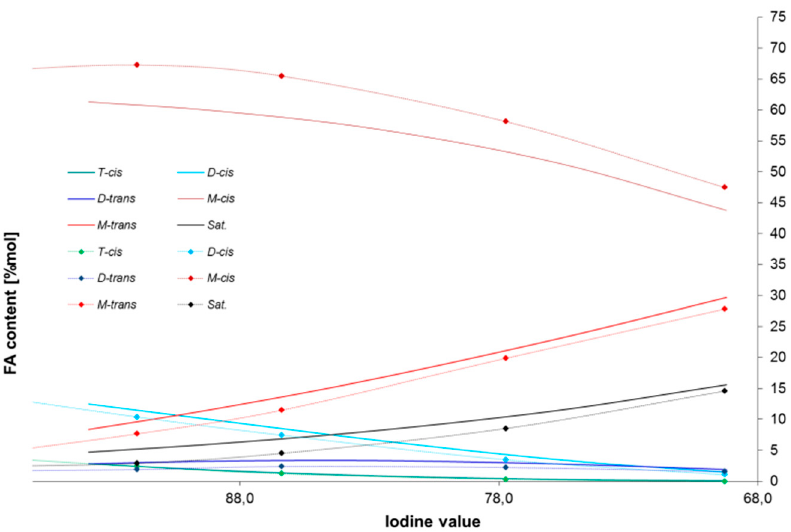
Figure 5. Predicted (solid line) and experimental (dotted line) fatty acids contents of canola oil hydrogenated with INS Ni_C catalyst. Reaction conditions: temperature 180 °C, H 2 pressure = 6 bar(a), agitation 950 rpm.